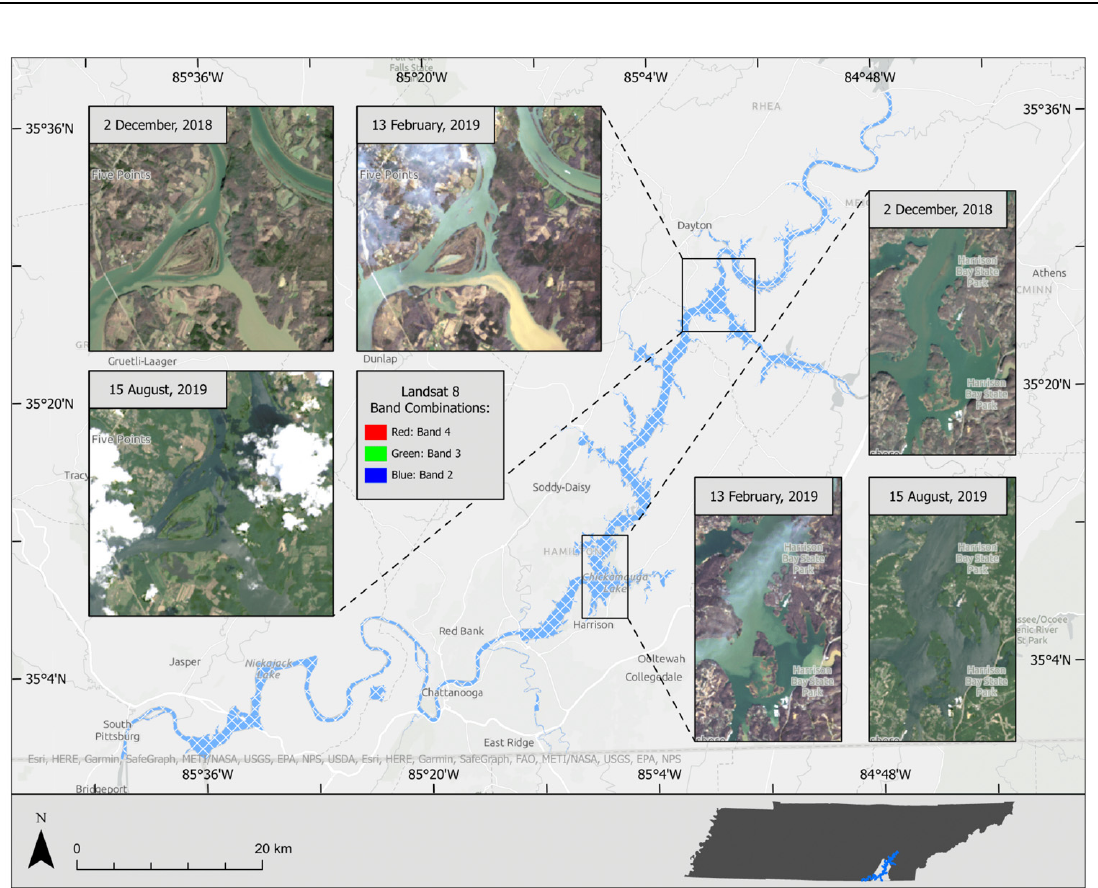
Figure 3. Landsat 8 OLI images acquired over the study site on 2 December 2018, 13 February 2019, and 15 August